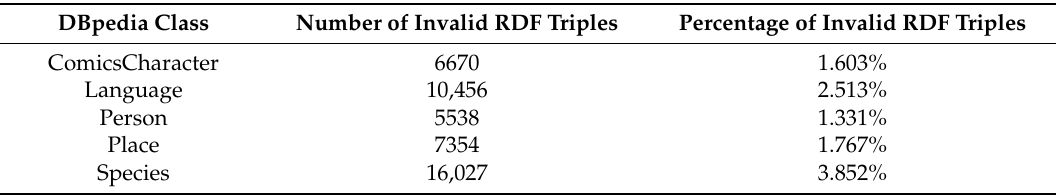
Table 21. DBpedia invalid RDF